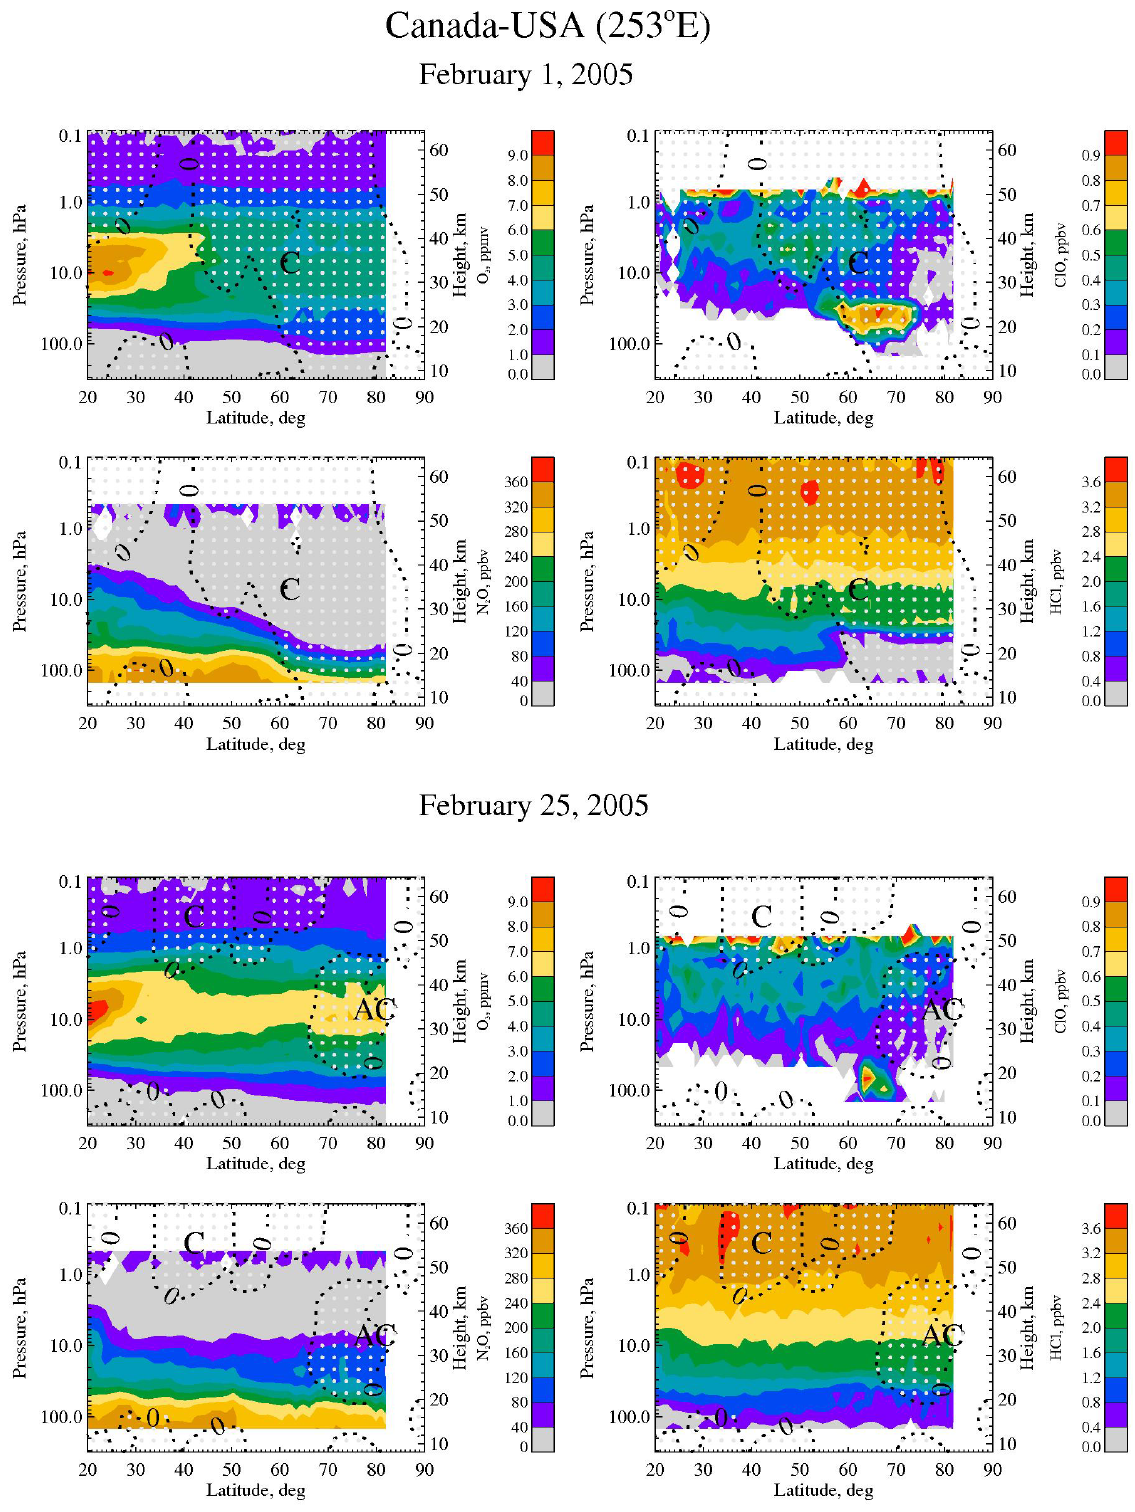
Fig. 6. Contour plots for mixing ratios of four chemicals (Aura MLS) are shown for 1 and 25 February, at the chosen longitudinal sector through Saskatoon-Platteville (253 ± 12.5 ◦ E). Otherwise details are as in Fig. 4. The hemispheric vortex edges are close to the southern boundaries of the major anticyclonic and cyclonic regions: please see text for any related